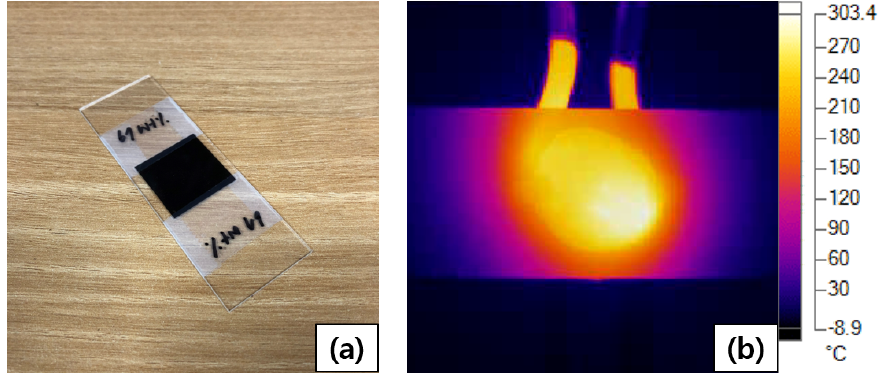
Figure 2. Heating temperature measurement using an infrared camera: ( a ) specimen and ( b ) measured image.